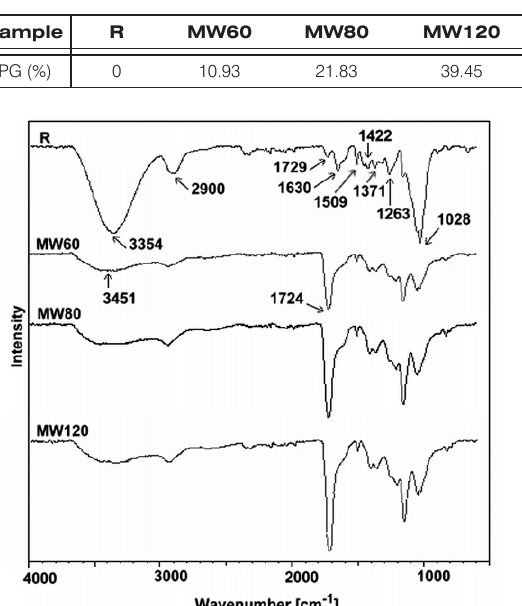
Table 2. Weight percent gain values for non-modified (R) and modified wood (MW).